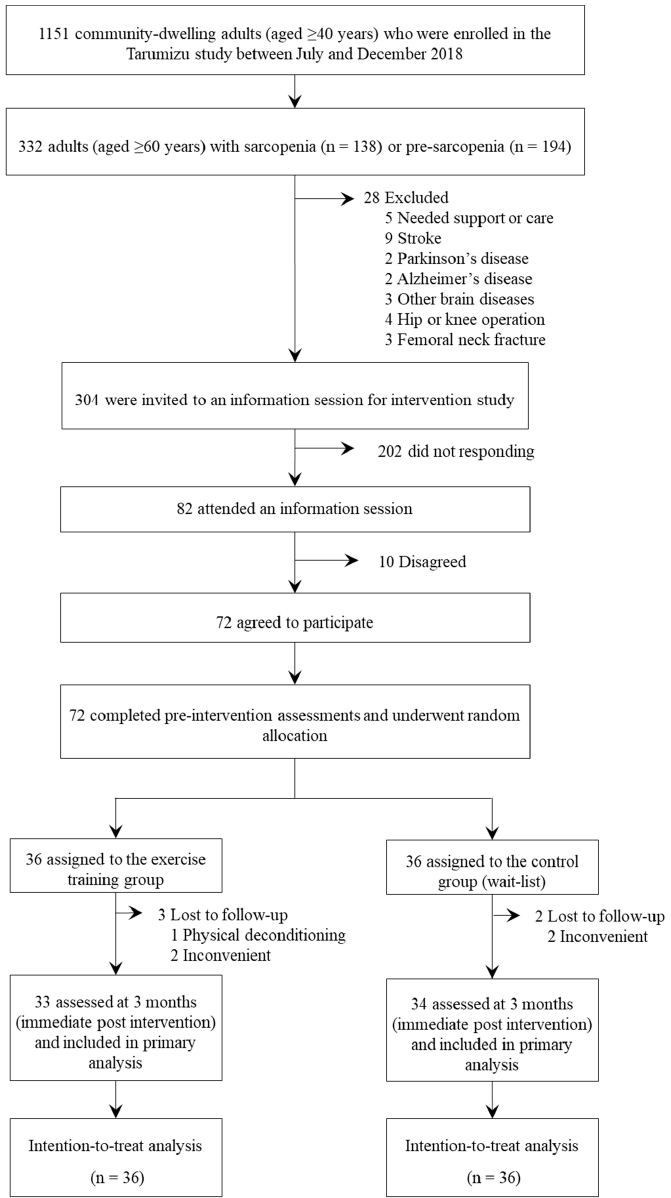
Figure 1. Flow diagram indicating participant progress through the trial.